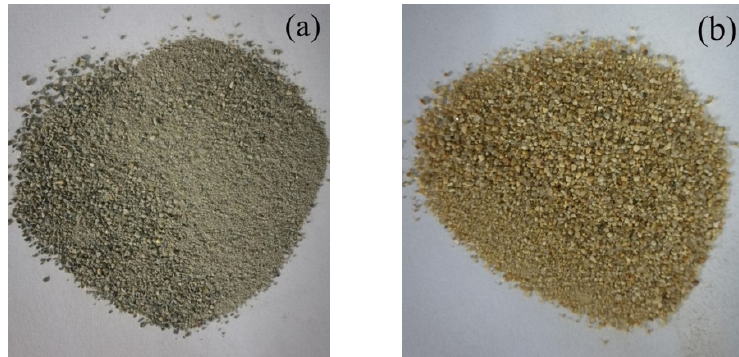
Materials 2020 , 13 , 679 Figure 5. Photos of ( a ) RFA and ( b ) natural fine aggregate (NFA). Figure 5. Photos of ( a ) RFA and ( b ) natural fine aggregate (NFA).